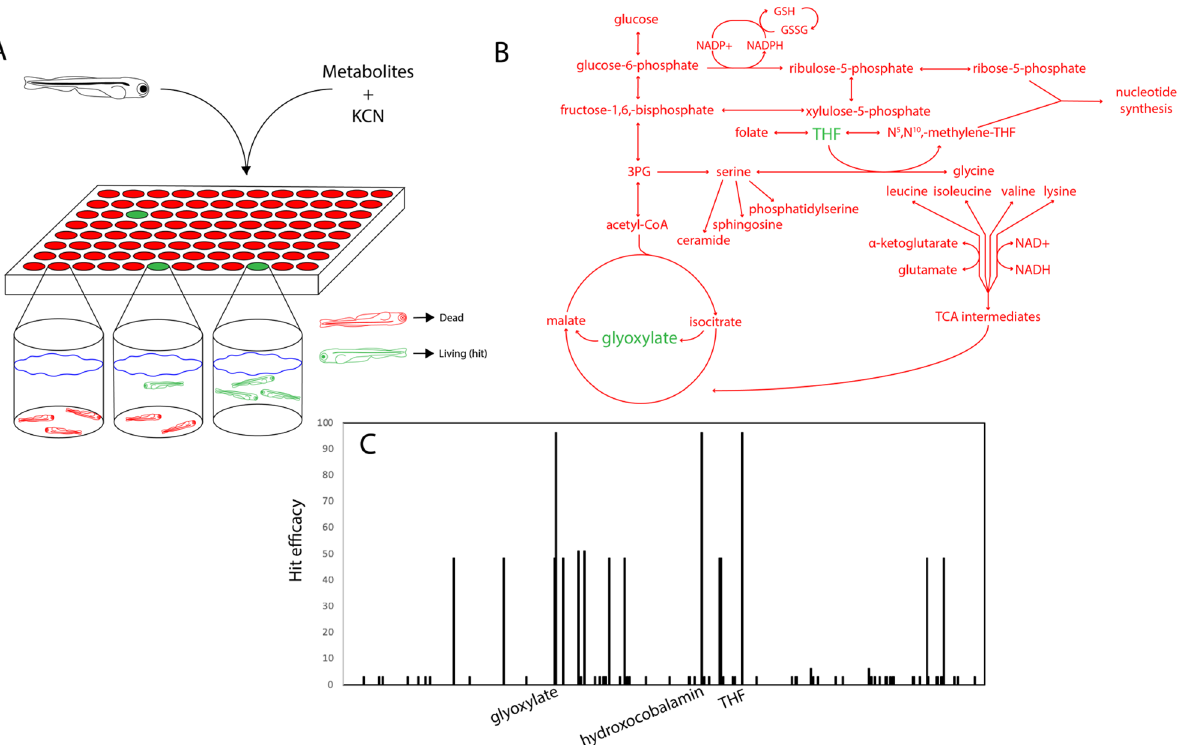
Figure 1. Glyoxylate identified as cyanide antidote in metabolite screen. ( A ) Schematic of the screening process for cyanide toxicity antidotes. 5 dpf zebrafish were added 3 per well to 96 well plates in E3 buffered with 20 mM HEPES and treated with 30 µM human metabolite and 10 µM KCN. ( B ) Metabolic map illustrating the breadth of the screen. Of the ~ 500 human-derived metabolites tested, THF and glyoxylate were the only molecules that yielded 24 h survival in both of the duplicate screens other than hydroxocobalamin, the positive control. ( C ) Hit efficacy plot denoting compound rescue capability. 2 points were assigned for 3 h touch responsiveness and 50 points were assigned for 24 h survival after each of the 2 screens (e.g., a compound that produces 24 h survival in both screens receives a score of 100, one that produces 3 h touch responsiveness in one and 24 h survival in the other receives a score of 52). Each peak represents one compound and its corresponding efficacy